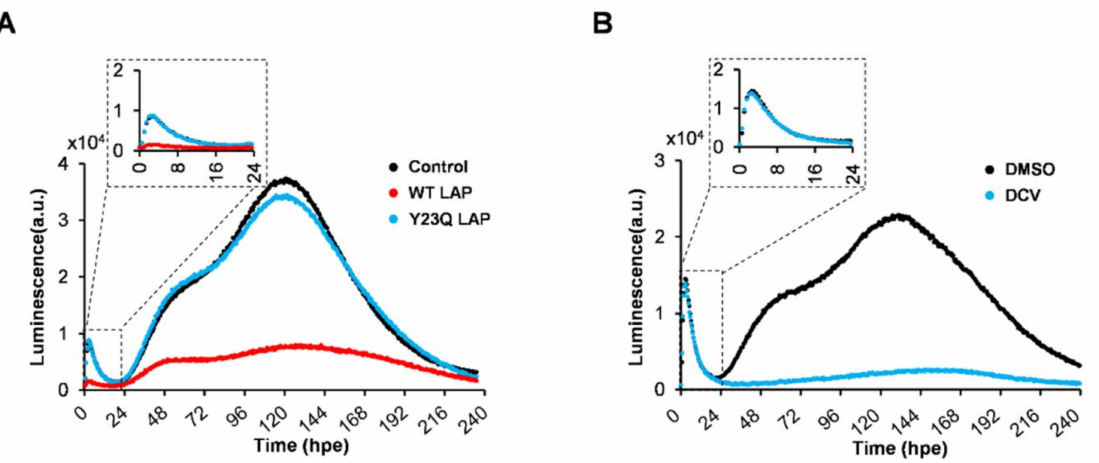
Figure 2. Effects of La peptide (LAP) and NS5A inhibitor daclatasvir (DCV) on the bioluminescence patterns in the replicon system developed. ( A ) SGR-JFH1/WT/SLG RNA was pre-mixed with WT LAP (red line), Y23Q LAP (blue line) or, control (electroporation reagent only; black line), followed by incubating at 37 ◦ C for 1 h and then electroporated into HuH-7T1 cells. Luciferase activity was kinetically recorded by Kronos Dio. Inset: plots of data obtained from the time range of 0 to 24 h are shown. ( B ) SGR-JFH1/WT/SLG RNA was electroporated into HuH-7T1 cells. Immediately after electroporation, the cells were cultured in the medium containing D-luciferin with or without 0.08 nM DCV. Luciferase activity was chronologically recorded by Kronos Dio. Inset: plots of data obtained from the time range of 0 to 24 h are